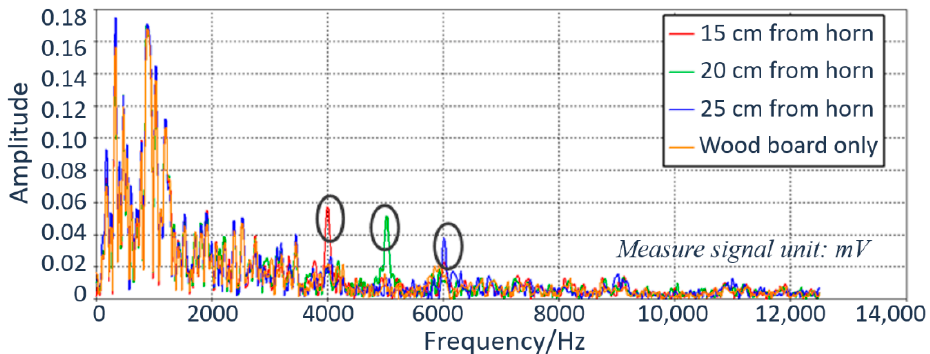
Figure 6. FFT of the output signal of the F-band swept-FM system. Peak signal components of 4.0, 5.0, and 6.0 kHz are observed when the target distance is 15, 20, and 25 cm from the antenna horn.